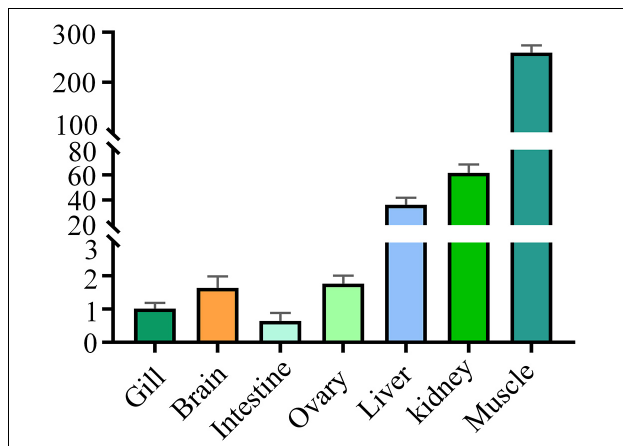
FIGURE 2 | Expression patterns of DM-lepa in different tissues. The y axis indicates the relatively expression level with associated standard error bars,